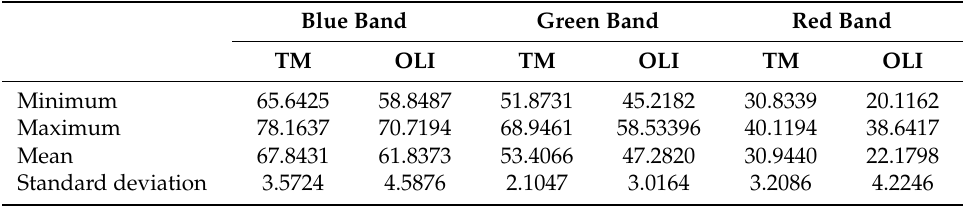
Table 9. Deep-water statistics for Landsat 5 TM and Landsat 8 OLI visible bands. Blue Band Green Band